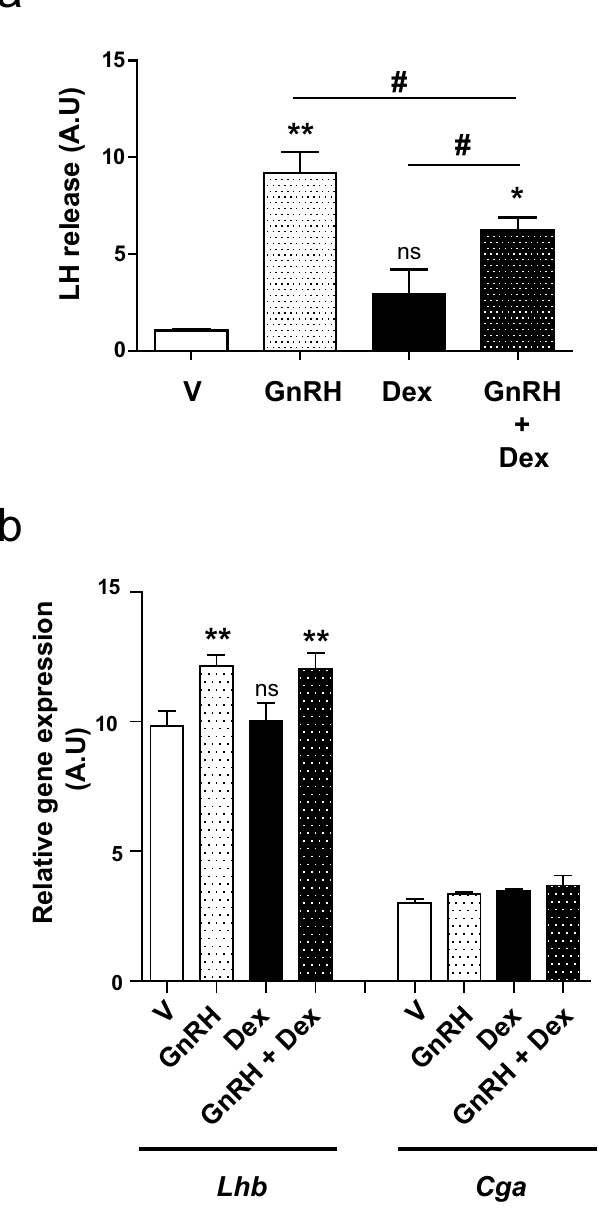
Figure 5. GC prevent GnRH-induced LH secretion in mice pituitary explants. ( a ) Pituitary explants were either treated with GnRH (10 − 8 M), Dex (10 − 7 M) or co-incubated with these two hormones for 1 h at 37 °C. LH concentrations were assayed in the culture supernatants as described in Methods. LH release after hormonal treatment was quantified (ng/ml) in comparison with LH amount measured in basal condition (pre-stimulation). GnRH significantly induced LH release when compared to vehicle. This effect significantly decreased after co-incubation of GnRH with Dex. One-way ANOVA with Dunnett’s post-test, * p < 0.05, ** p < 0.01. # p < 0.05 comparing GnRH and Dex co-treatment with each individual treatment. ( b ) L β T2 were treated with GnRH (10 − 8 M), Dex (10 − 7 M) or co-incubated with these two hormones for 1 h at 37 °C before RT- qPCR to follow the expression of genes encoding the common α -glycoprotein subunit ( Cga ) and the β -subunit of LH ( Lhb ). Data show relative expression (arbitrary units) normalized with the reference gene 36b4 . Within 1 h, GnRH significantly stimulated Lhb expression (by approximately 1.24-fold above basal), whereas Dex did not have any effects either alone or associated with GnRH. One-way ANOVA with Newman-Keuls Multiple Comparison posttest, n = 3, ** p <